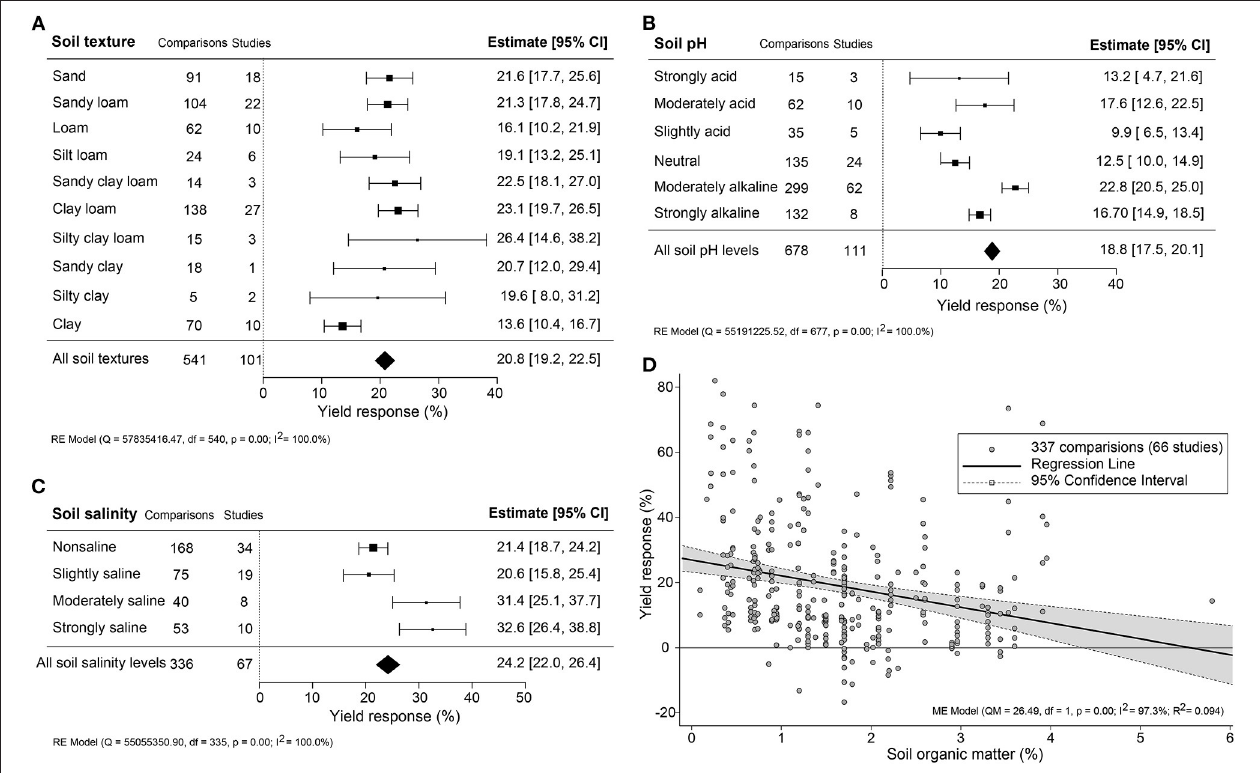
FIGURE 6 | Percentage yield response to biostimulant application affected by the soil properties, including soil (A) texture, (B) pH, (C) salinity, and (D) organic matter (%). The point size correlates to the estimate’s precision, and the error bars represent 95% confidence intervals (CI) of mean estimated effect sizes. The number of comparisons and studies is indicated in each line or each legend. The combined effect estimates and the heterogeneity test on the models [random-effect models (RE) in (A – C) , and mixed-effect model (ME) in (D) ] were summarized at the bottom, where the heterogeneity test is significant ( p < 0.001) and I 2 ≥ 75% implies substantial